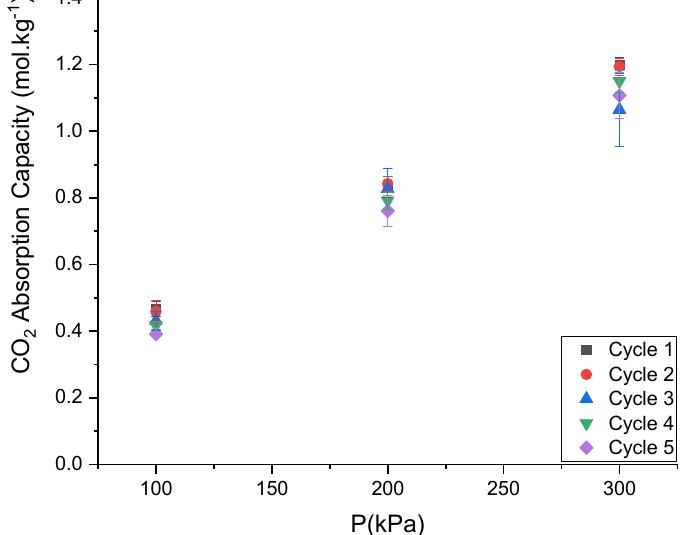
Figure 15. Variation of the CO 2 absorption capacity of ChCl:LvAc (1:2:0) over five consecutive absorption/desorption cycles: values measured at 25 °C and 250 rpm.